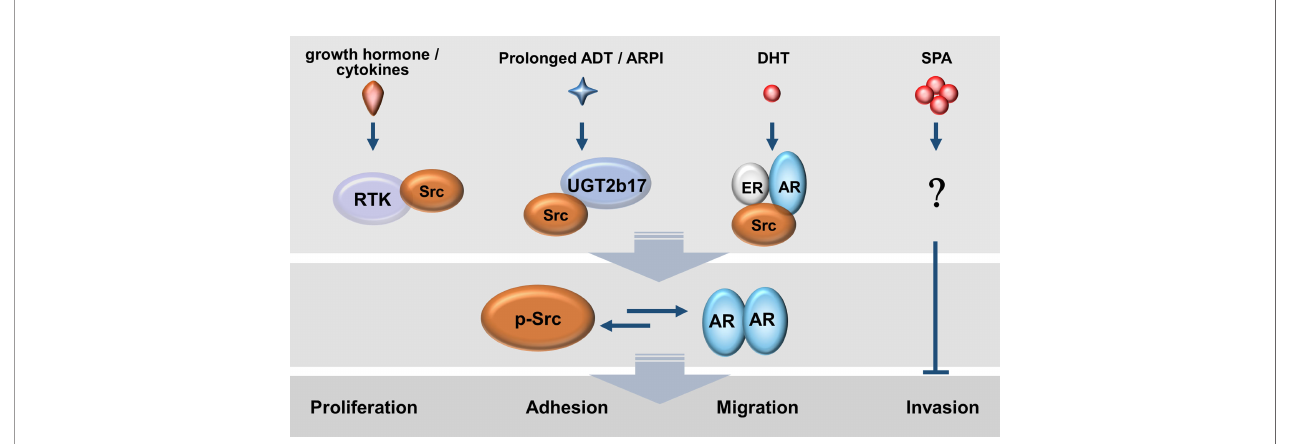
FIGURE 3 | Mutual activations between AR and Src kinase exist in prostate cancer cells under various androgen conditions. Enriched growth factors and tumour- promoting cytokines as well as de novo androgen synthesis by tumour cells allow a persistent activation of the AR-Src